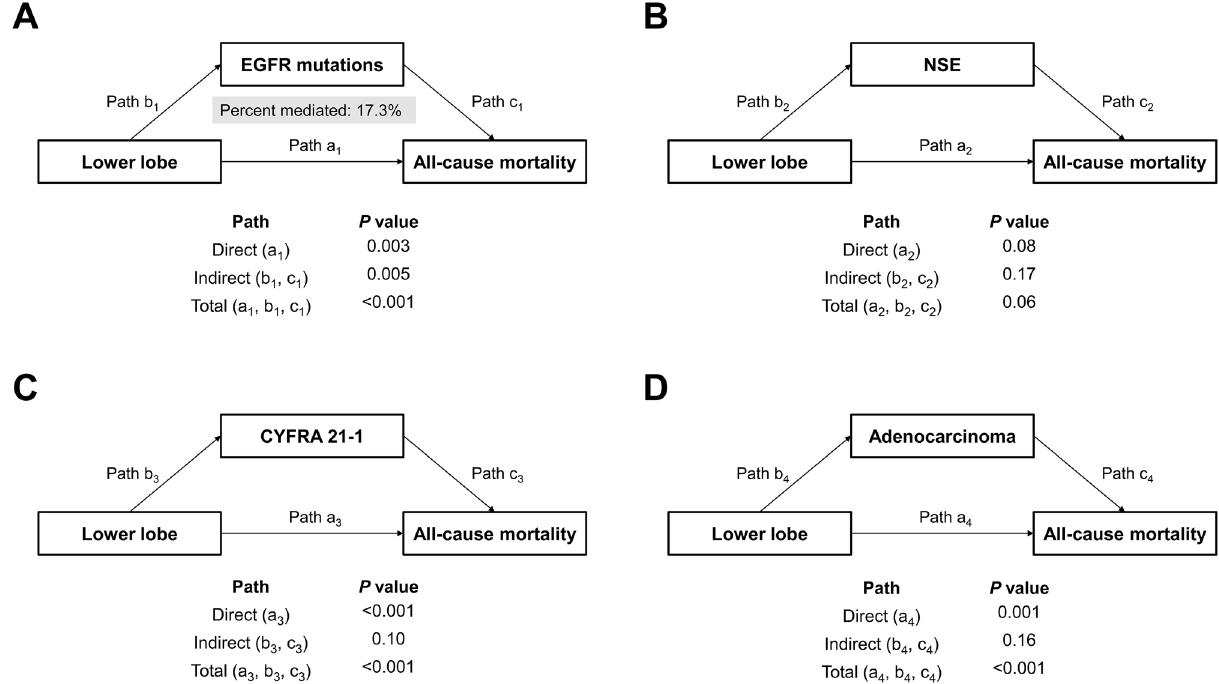
Figure 3. Causal mediation analysis in non-small cell lung cancer patients. ( A ) Mediation analysis for indirect effect of EGFR mutations; ( B ) Mediation analysis for indirect effect of NSE; ( C ) Mediation analysis for indirect effect of CYFRA; ( D ) Mediation analysis for indirect effect of adenocarcinoma. CYFRA, cytokeratin fragment; EGFR, epidermal growth factor receptor mutations; NSE, neuron-specific